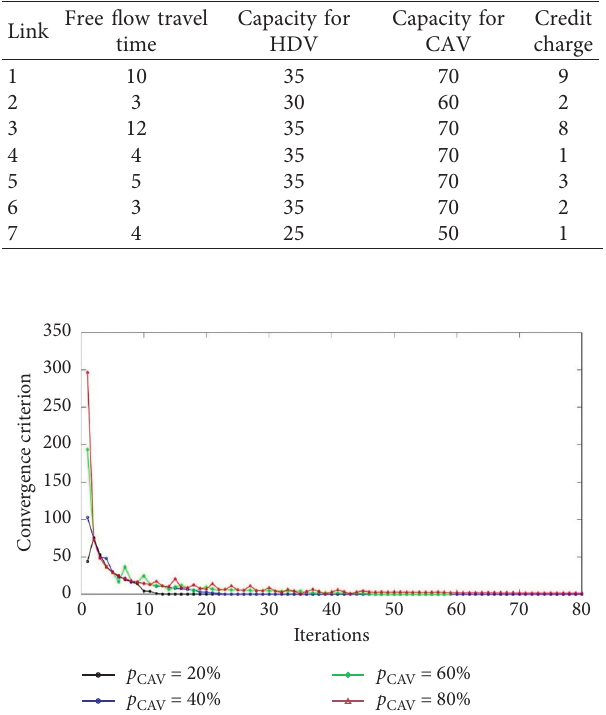
Figure 2: Convergence results for unit credit price under various CAV penetration